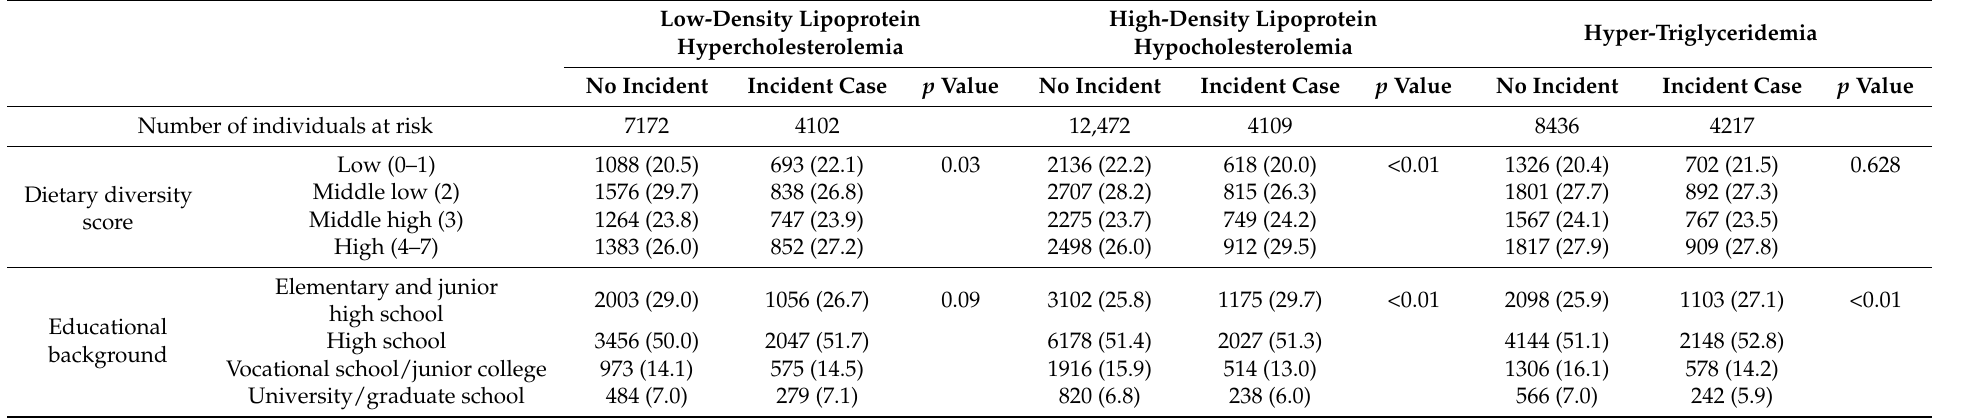
Table 2. Results of the analysis of earthquake-related, sociopsychological, and lifestyle factors of the